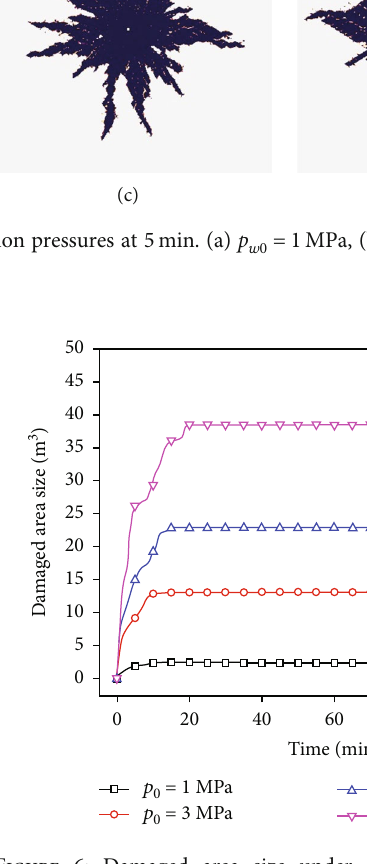
= 1 MPa , (b) p = 3MPa , (c) p = w 0 w 0 w 0